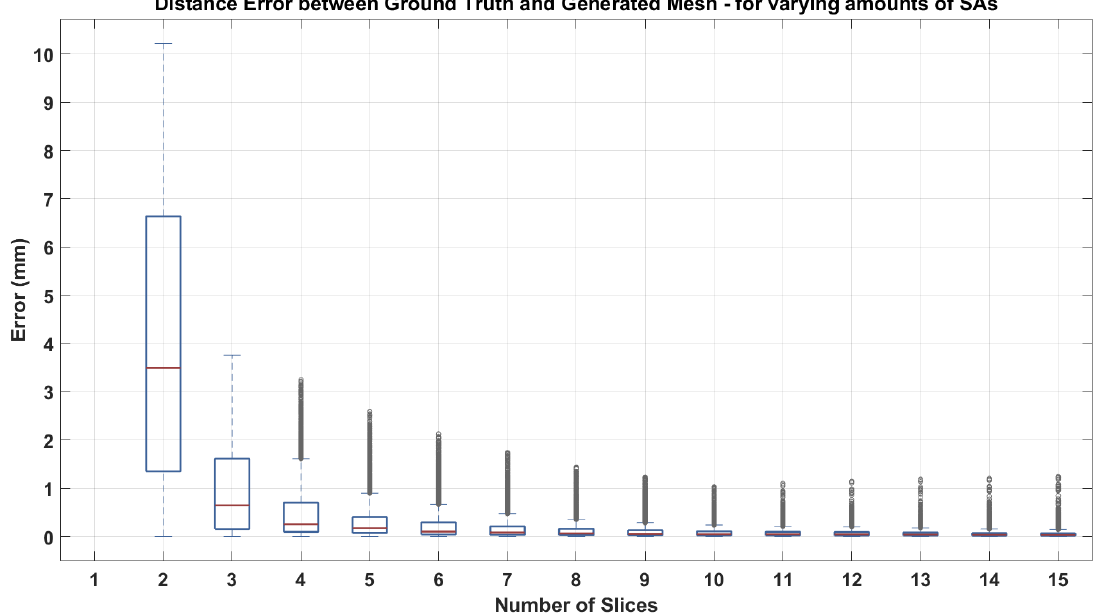
Figure 5. Impact of increasing the number of SAX contours on the error distance between the generated mesh and the ground truth